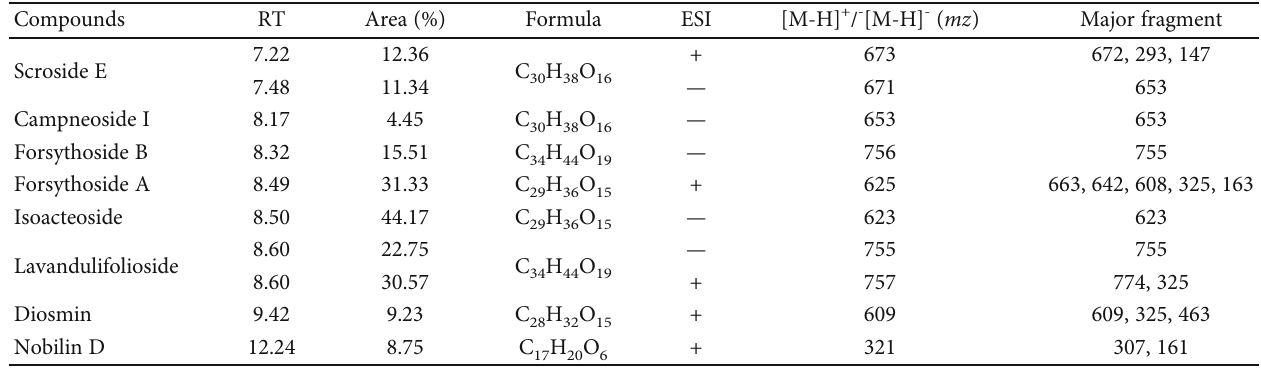
Table 3: Major compounds identi fi ed in the ethanol extract of P. serratifolia leaves using LC-QTOF-MS/MS based on positive and negative modes.